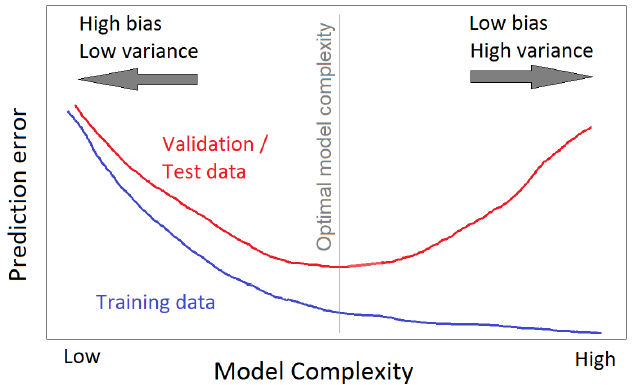
Figure 5. Training and validation/test errors as a function of model complexity. Optimal model complexity yields a balanced model that has neither large bias (data underfitting) nor large variance (data overfitting).